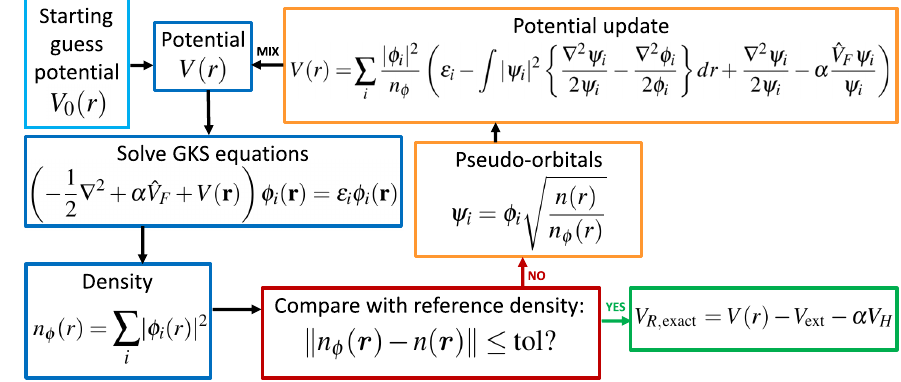
FIG. 1. A schematic representation of the generalized Kohn-Sham inversion algorithm used in this work. See text for